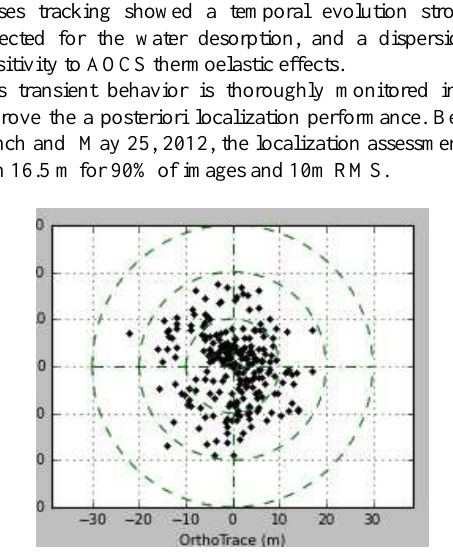
Figure 7 : A posteriori localization performance assessed April 5, 2012 Because of AOCS calibration still in progress, linear drifts in the image were 1 µ rad per second on roll direction and 0.8 µ rad per second on pitch direction in the same period . Performance will be updated in the coming months after complete characterization of the phenomena. But an already checked Improvement will achieve a better assessment of localization than 12 meters to 90% , performed with the viewing line depointed less than 30 °. It will be available for month of